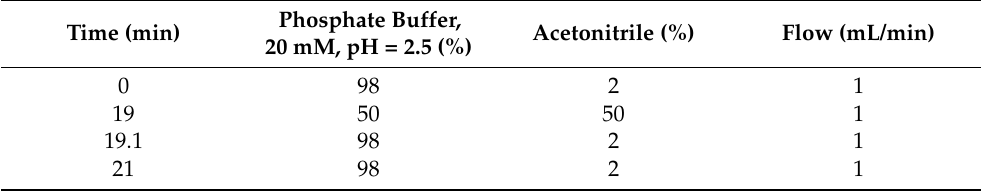
Table 1. Brief presentation of the mobile phase elution gradient program.